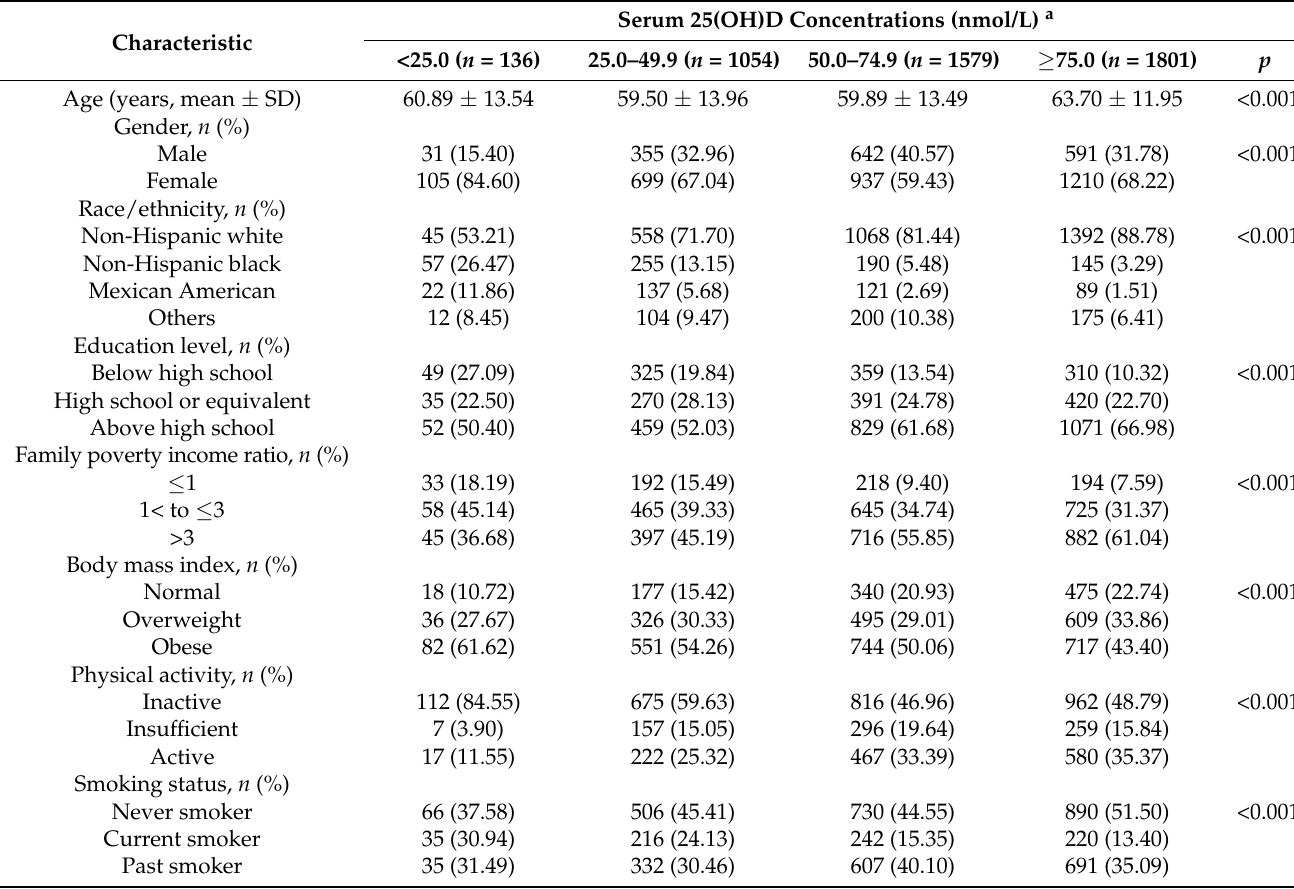
Table 1. Basic characteristics of participants with OA according to serum 25(OH)D concentrations in NHANES III and NHANES